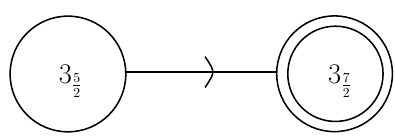
Figure 3 . The dual of theory T x with SU(3) = Z 3 gauged at level k = 7 = 2. The theory is dual to a chiral (cid:12)eld with cubic superpotential. The double circle denotes SU(3) = Z 3 gauging with the single circle denoting an SU(3) gauge